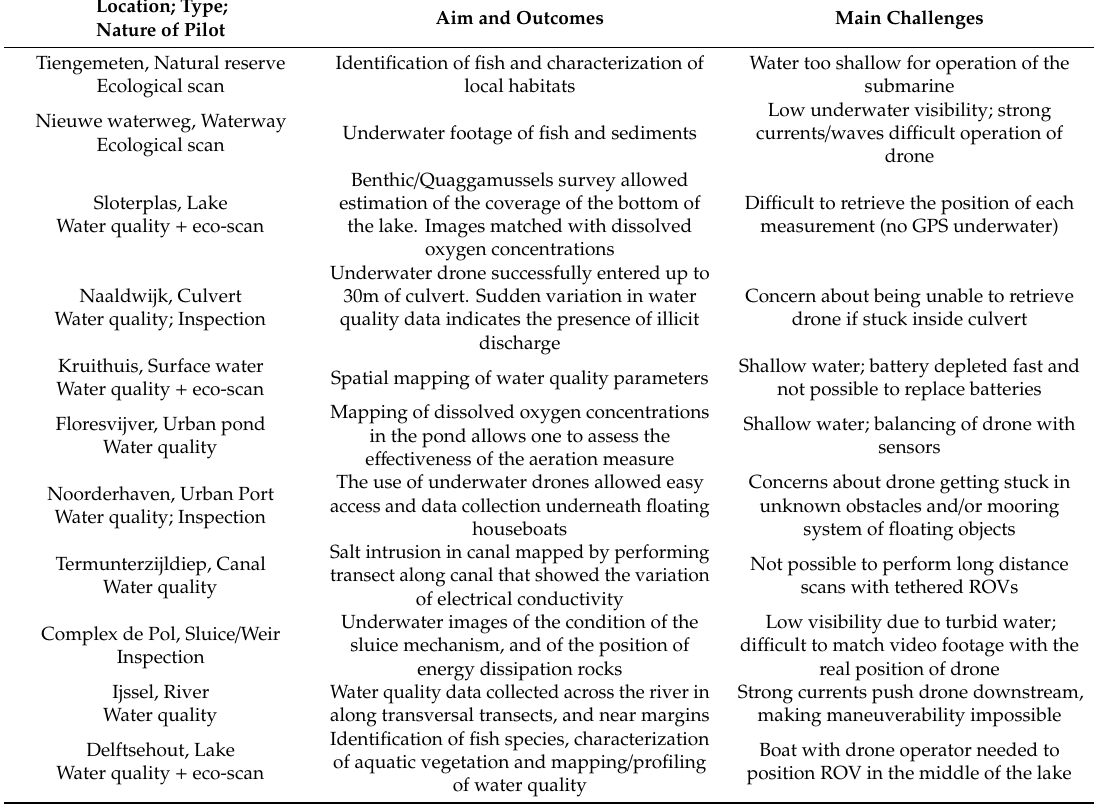
Table 5. Summary of the di ff erent Dutch case